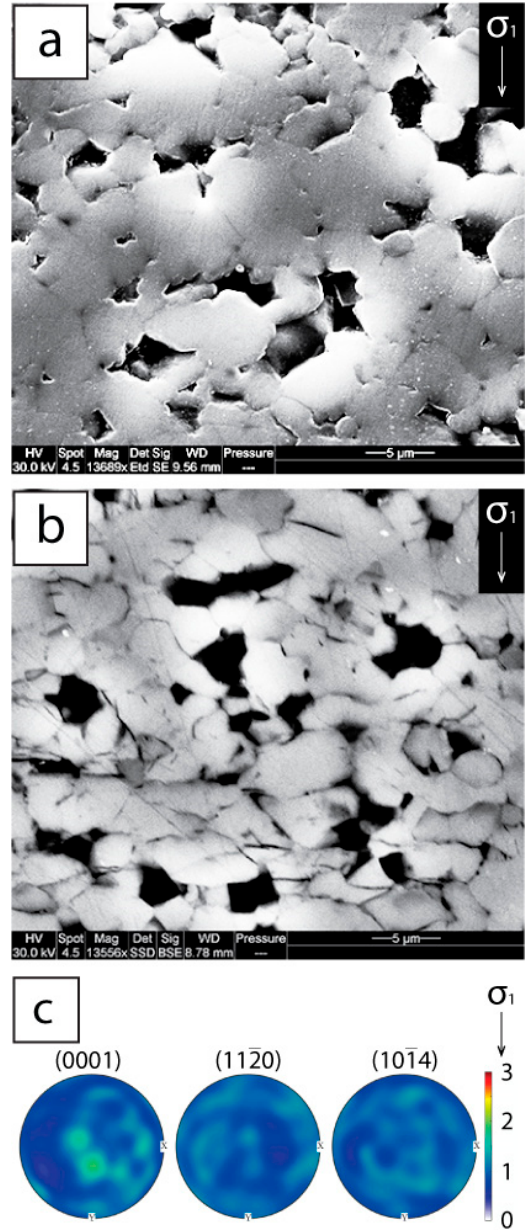
Figure 7. Microstructures in fine-grained magnesite cylinders deformed at T = 750 °C in the Griggs apparatus ( a ) and DDIA ( b ) include rounded grains and increased porosity relative to the starting material. (SEM BSE images; ( a ), Z-100, T = 750 °C, P eff = 0.76 GPa, 𝜀(cid:4662) = 2.1 × 10 − 5 ·s − 1 , σ diff = 0.38 GPa; ( b ), MAG_020, T = 750 °C, P eff = 6.3–3.8 GPa, 𝜀(cid:4662) ~ 10 − 5 ·s − 1 , σ diff = 1.6 GPa). ( c ) EBSD measurements of poles to basal (0001), prism (11–20), and rhomb (10–14) planes indicate that no discernable LPO has developed in the samples deformed at T = 750 °C (Z-100, P eff = 0.76 GPa, 𝜀(cid:4662) = 2.1 × 10 − 5 ·s − 1 , σ diff = 0.38 GPa, n = 1366).